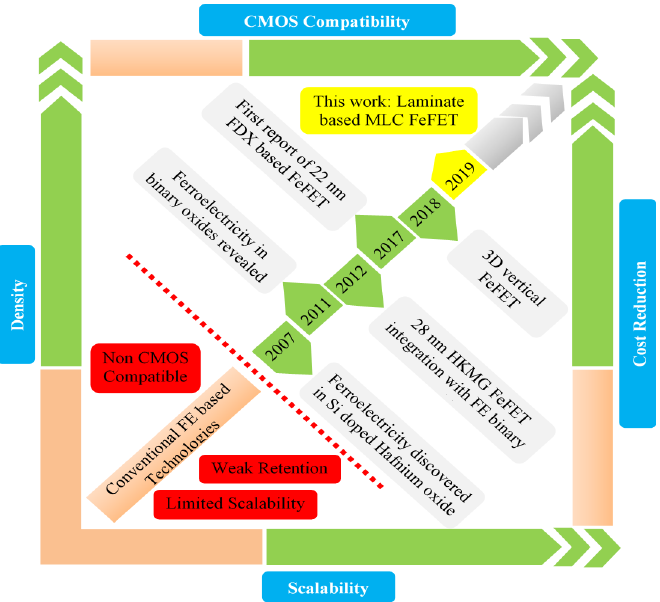
Figure 1. The FeFET memory development trend sparked by the discovery of ferroelectricity in fluorite structure hafnium oxide materials and driven by the key technological merits: cost, density, scalability, and CMOS compatibility. Reproduced with permission from [17] T. Ali et al., IEDM; published by IEEE, Copyright 2019, IEEE.